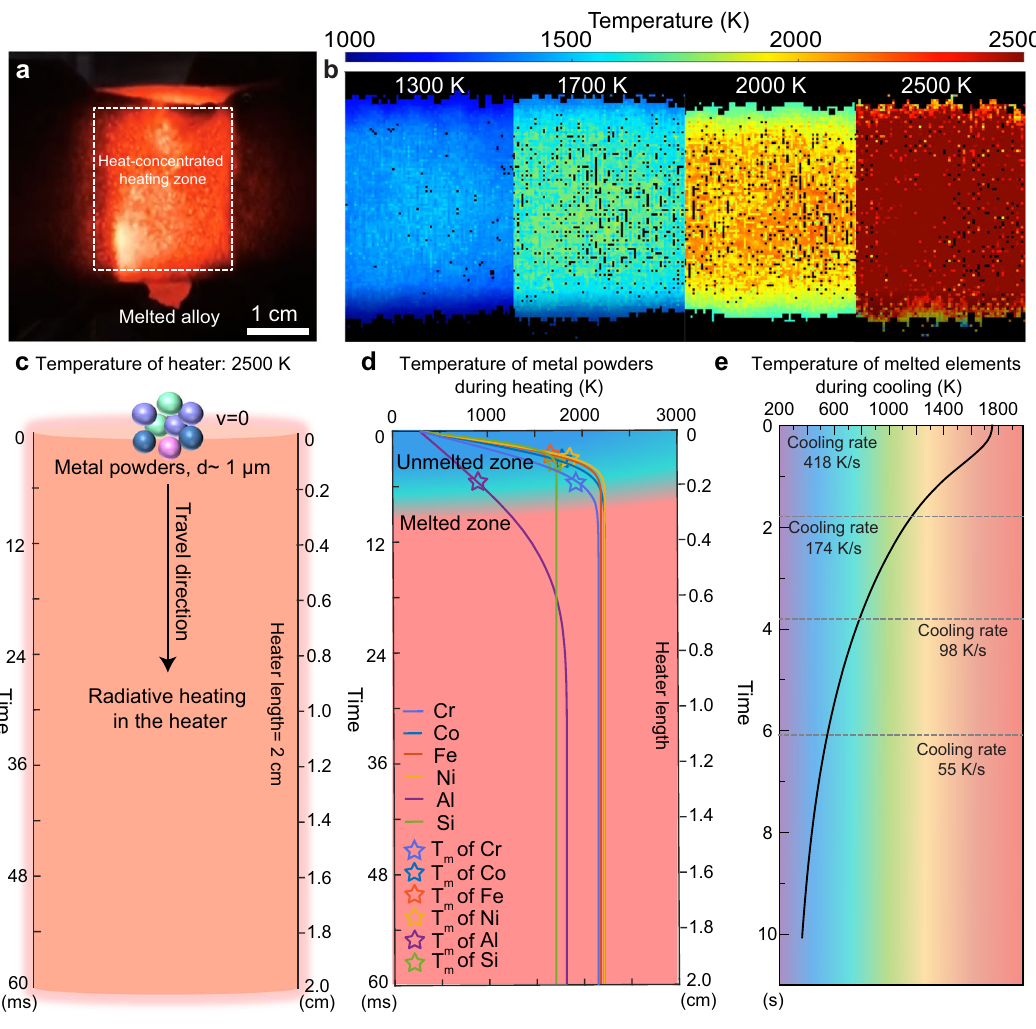
Fig.2|Temperatureoftheheat-concentratedzoneandtheheatingandcooling process of the metal powders. a Photograph of the heat-concentrated heater extruding a melted bulk MPEA droplet. When applying a voltage, the heat is con- centrated in the column region, emitting a bright light, while the edges of the carbonfeltwithlowerelectricalresistanceremaindark. b Temperaturemappingof the heating source at different input powers (~150W, ~400W, ~800W, ~2000W, fromleftto right). c Schematicof the metalpowders traveling through theheating